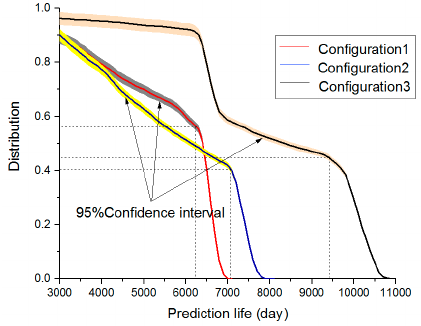
Figure 18. Life distribution with different configurations under work mode M1.